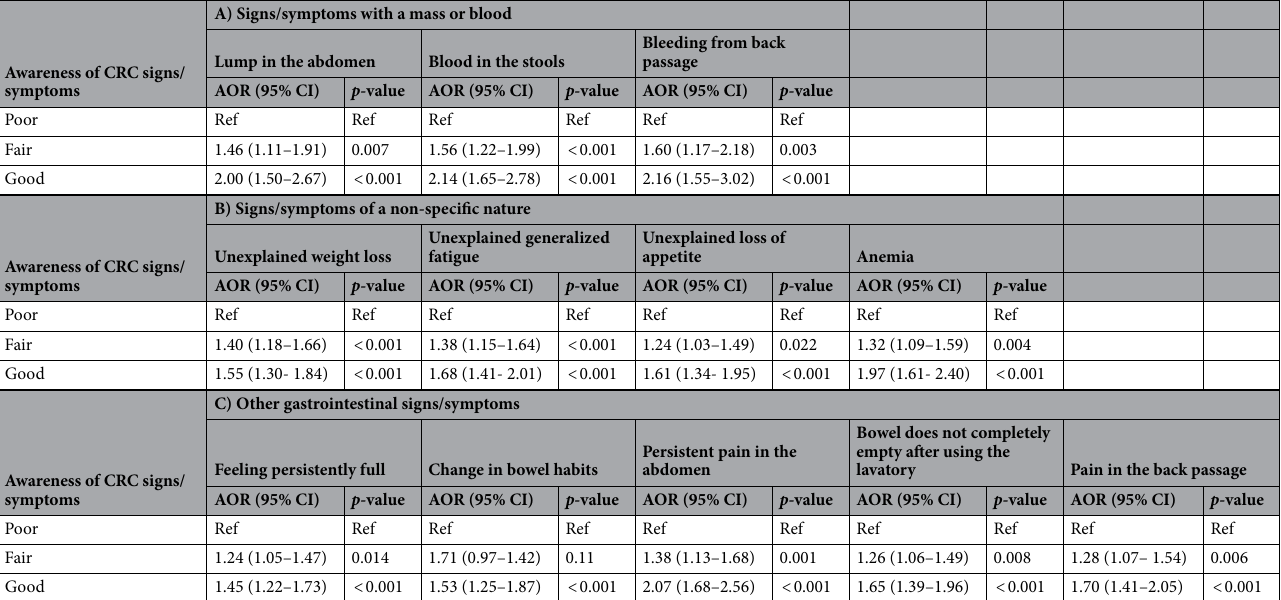
Table 4. Multivariable logistic regression analyzing the association between seeking medical advice within a week and awareness of colorectal cancer symptoms. AOR = adjusted odds ratio, CI = confidence interval, CRC = colorectal cancer. All analyses were adjusted for age-group, gender, educational level, occupation, monthly income, having a chronic disease, following a vegetarian diet, knowing someone with cancer, marital status, residency, and site of data collection. The outcome in all models is binary, where answers with ‘1–7 days’ were considered as ‘yes’ and all other answers were considered as ‘no’. All p -values are for the multivariable logistic regression analysis.